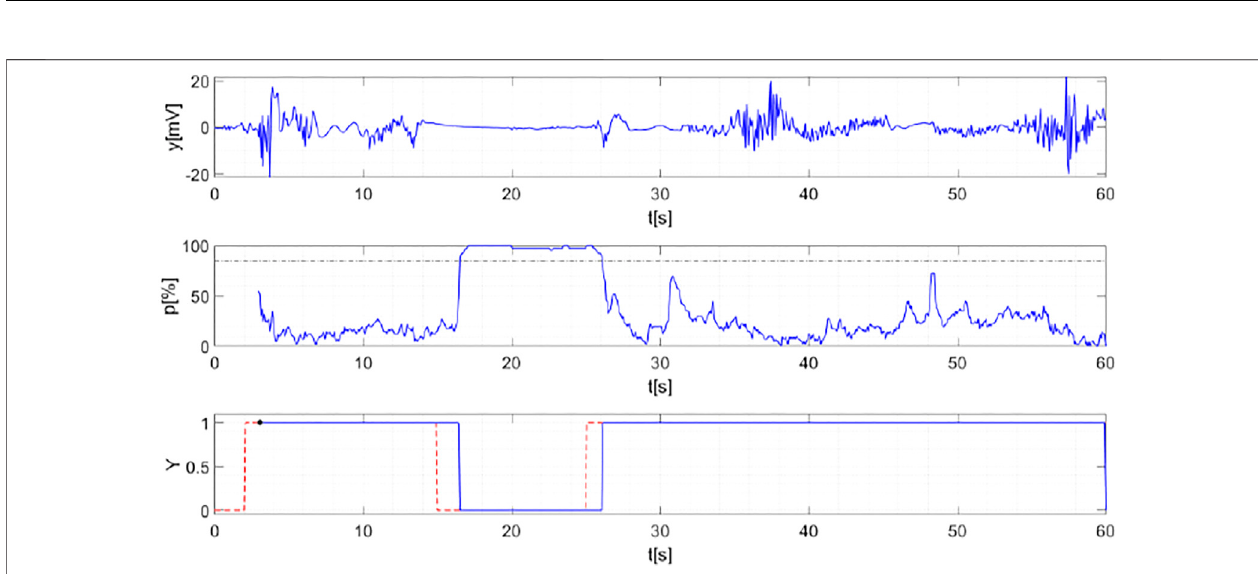
FIGURE13| RadarsignalmeasuredinTest1(toppanel).Percentageofsamplesfallingintheinterval[ − A p , A p ](solidline)comparedtooptimalthreshold ξ p (dashed line) (middle panel). HM output (solid line) compared to ground truth (dashed